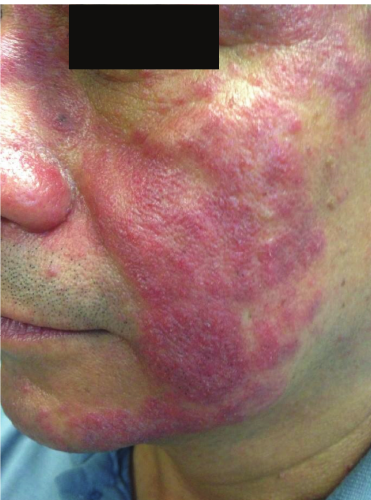
Figure 2: Profile view demonstrating erythematous, indurated papules and plaques as well as pustules with a sharp demarcation of the erythema to surrounding normal skin.